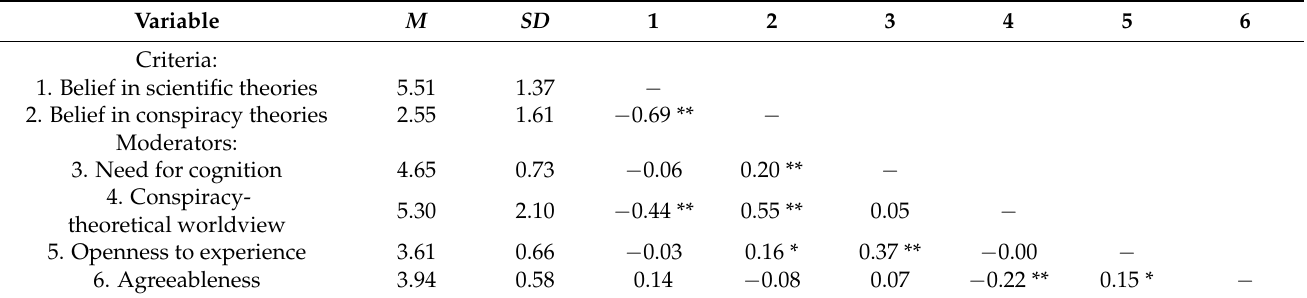
Table 1. Means, standard deviations, and